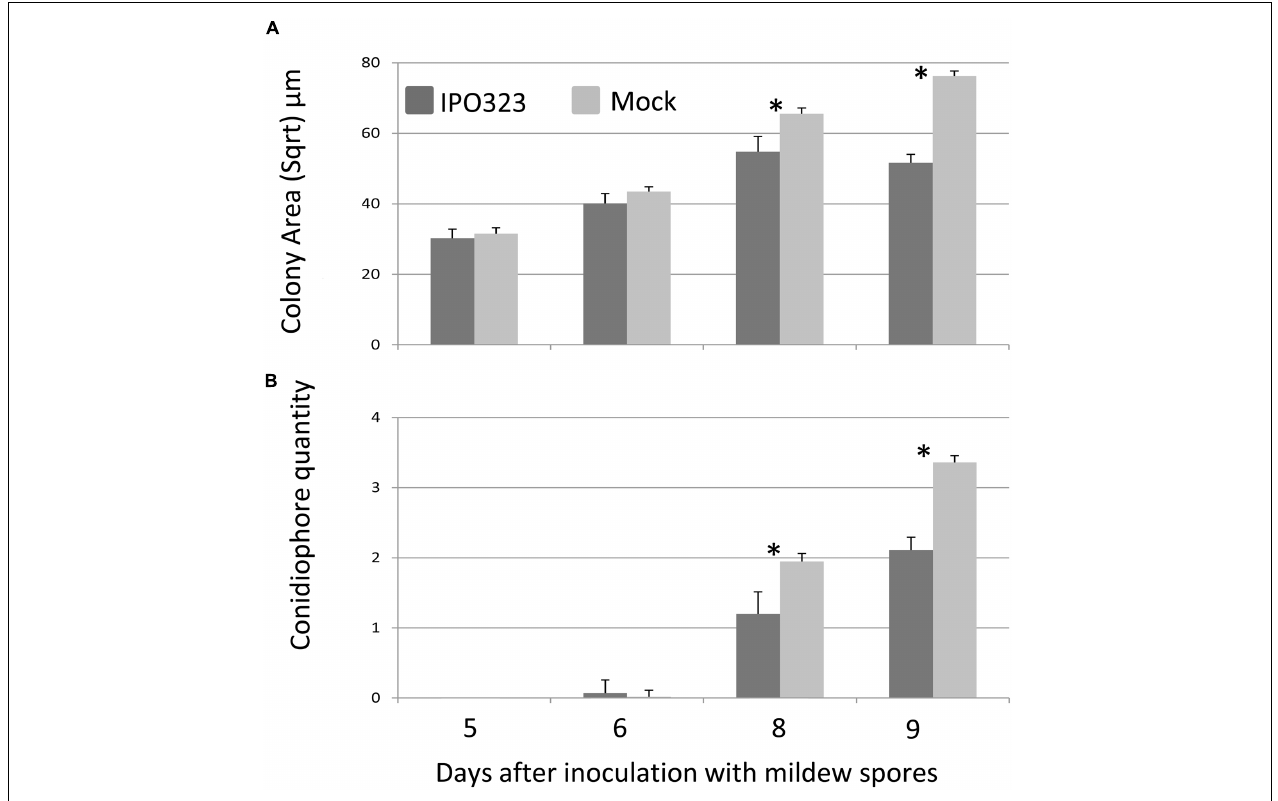
FIGURE 6 | Effect of pre-inoculation with virulent Z. tritici on the late stages of development of B. graminis f.sp. tritici ( Bgt ). Leaves of Longbow were sampled 5–9 days after inoculation with Bgt , after either pre-inoculation with Z. tritici isolate IPO323 or mock-inoculation. (A) Mean square root of colony area ( µ m) where the square root of the area is proportional to the length of the axis of the ellipse formed by the colony. (B) Mean number of conidiophores per colony (0–4 scale). Error bars are ± 1 SE of predicted means. ∗ P < 0.05 (Fisher’s protected least significant difference).